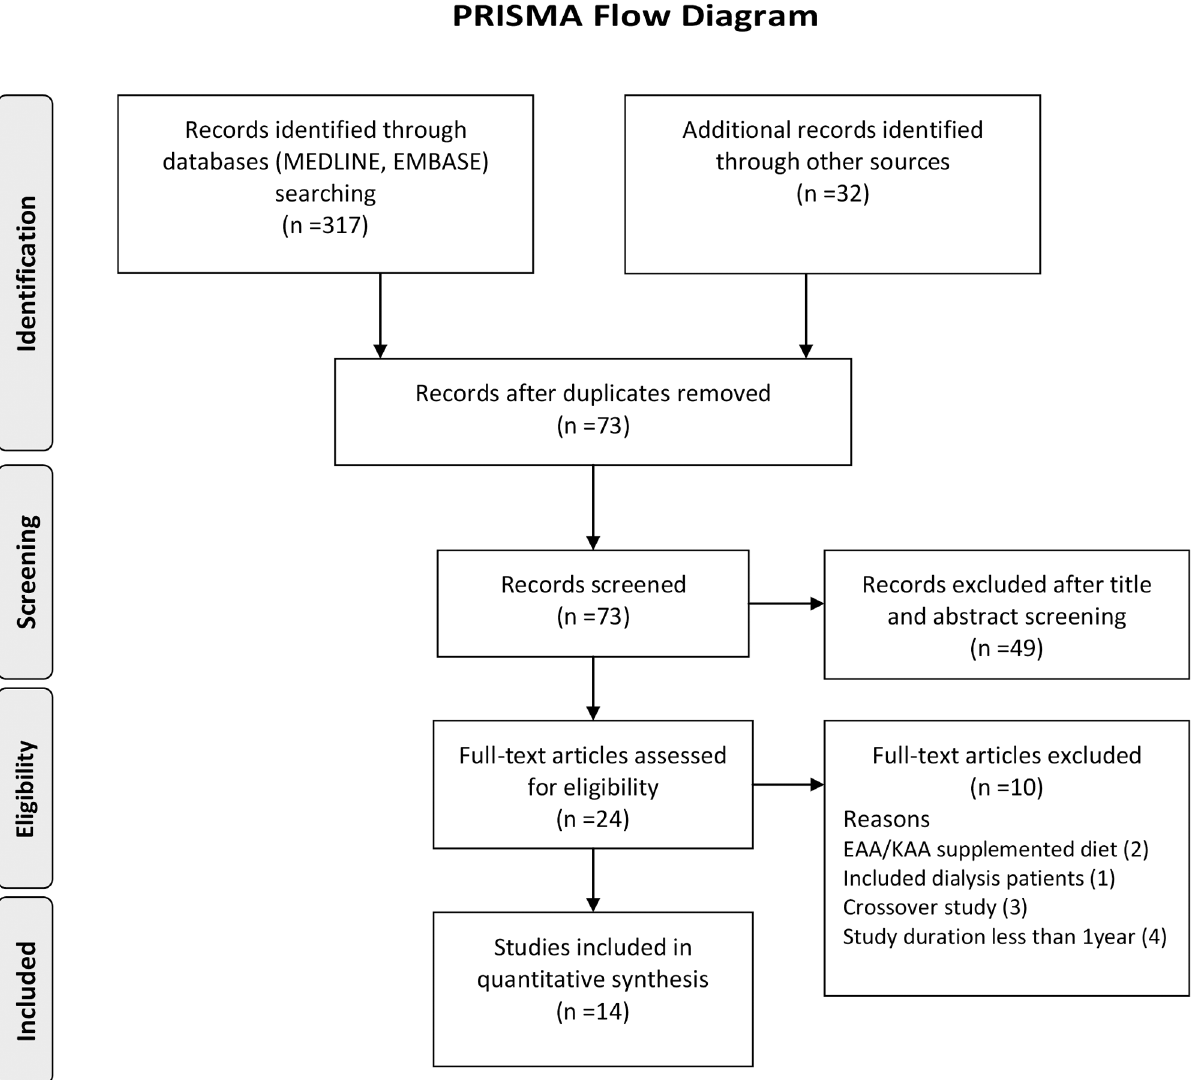
Fig 1. The PRISMA flow diagram for the study selection process. From: Moher D, Liberati A, Tetzlaff J, Altman DG, The PRISMA Group (2009). Preferred Reporting Items for Systematic Reviews and Meta-Analyses: The PRISMA Statement. PLoS Med 6(6): e1000097. doi:10.1371/journal.